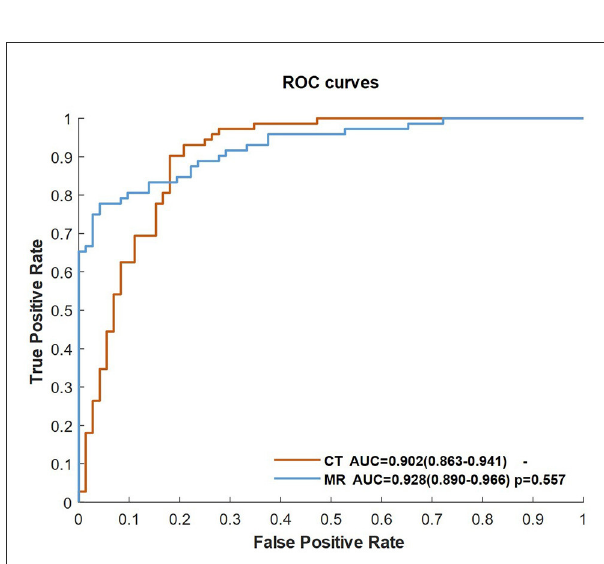
FIGURE4 ROC curves of the classifiers of the CNN trained by CBF, Tmax, and ROI masks of Tmax > 6s in the CT and MR groups.